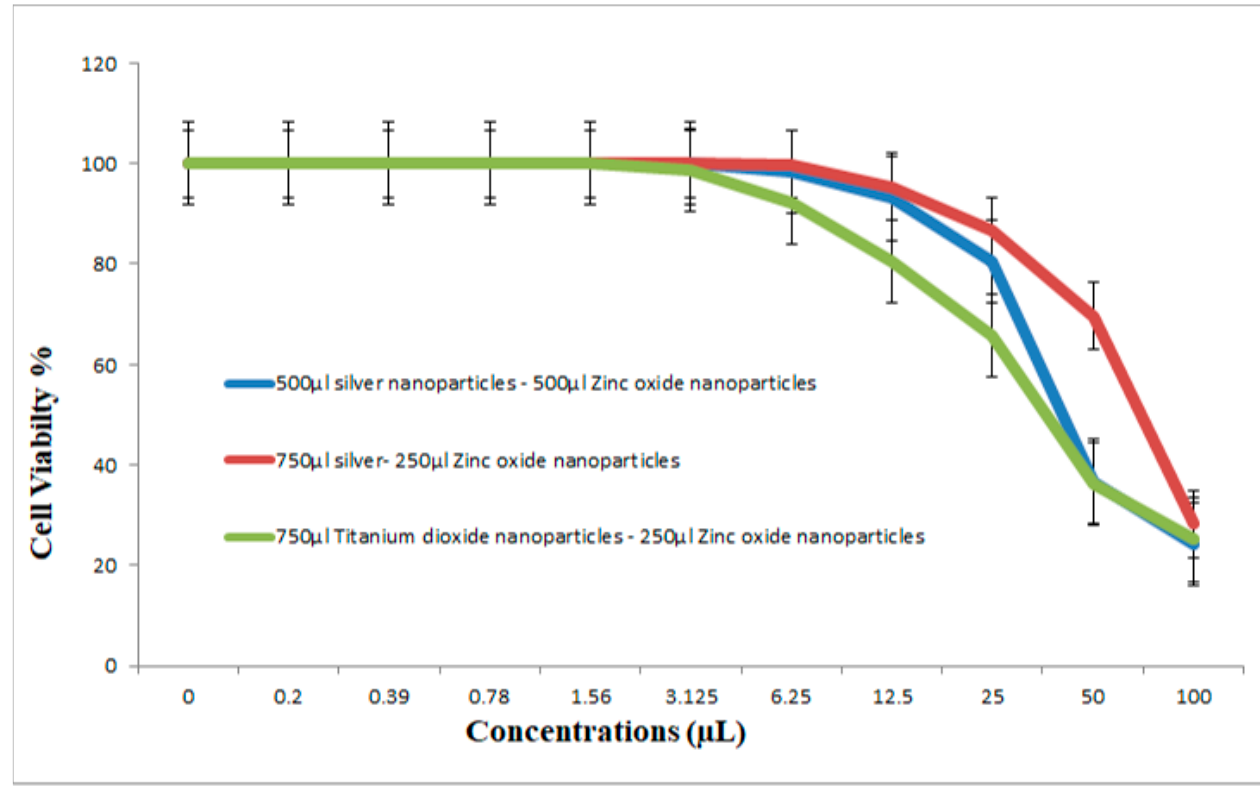
Figure 15. Viability of HCT-116 cells (colon carcinoma cell) (24 h incubation) and treatment with titanium dioxide biosynthe- sized nanoparticles. Composite 500 µ L silver nanoparticles–500 µ L zinc oxide nanoparticles; composite 750 µ L silver–250 µ L zinc oxide nanoparticles; composite 750 µ L titanium dioxide nanoparticles–250 µ L Zinc oxide